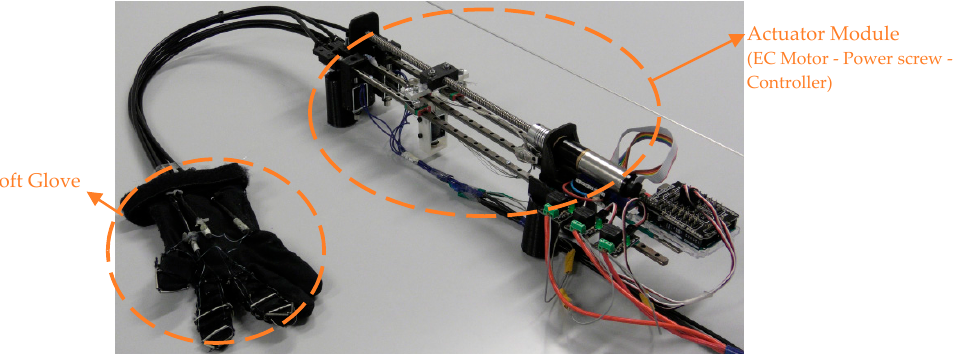
Figure 3. The implemented prototype. A power screw was used to transfer the power from the EC-motor to the flexion and extension mechanisms implemented on the soft glove.